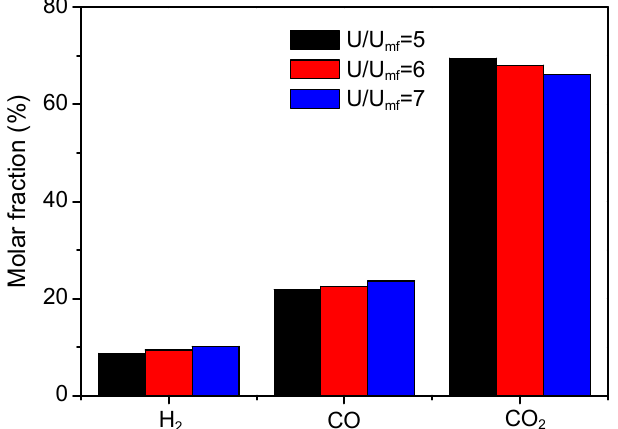
Figure 9. Distributions of N 2 -excluded flue gas concentrations (dry basis) in different fluidizing numbers.